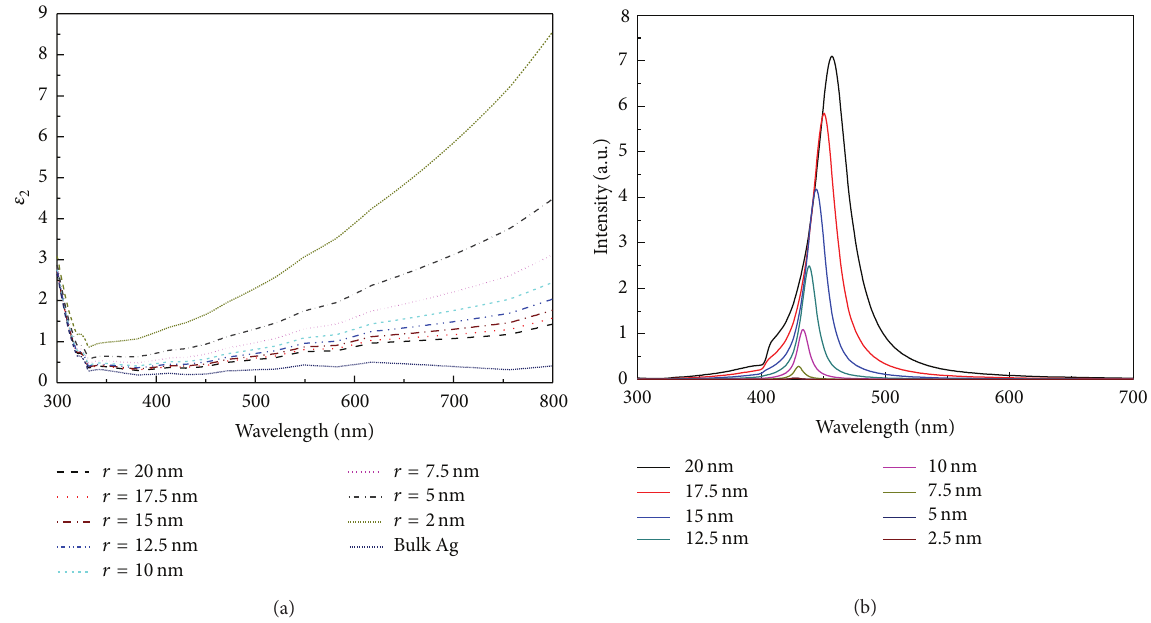
Figure 5: Theoretically estimated size dependent variation in imaginary part of dielectric constant of Ag nanoparticles (a) and Mie scattering intensity at scattering angle 180 ∘ , for the fixed refractive index of medium as 1.7